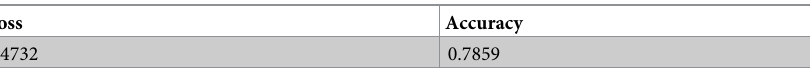
Table 3. Model evaluation.